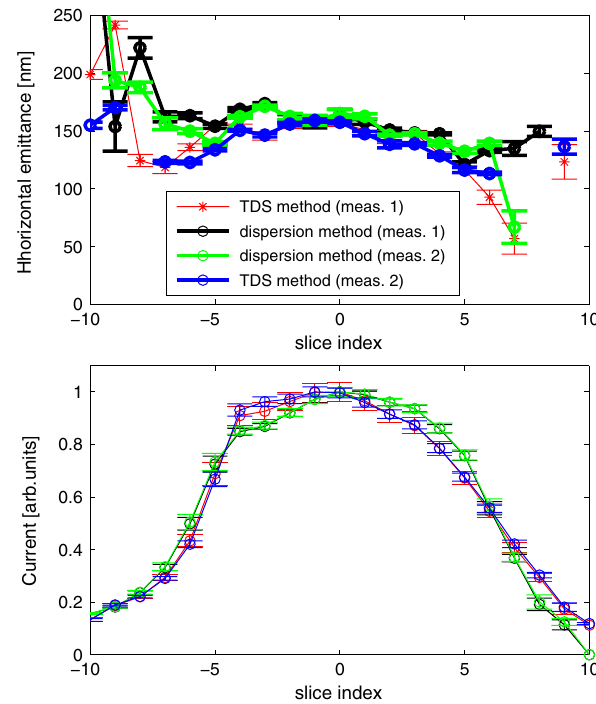
FIG. 8. Horizontal slice-emittance measurement. The upper plot shows the normalized slice emittance as a function of the slice index, the lower plot the relative current profile of the beam.